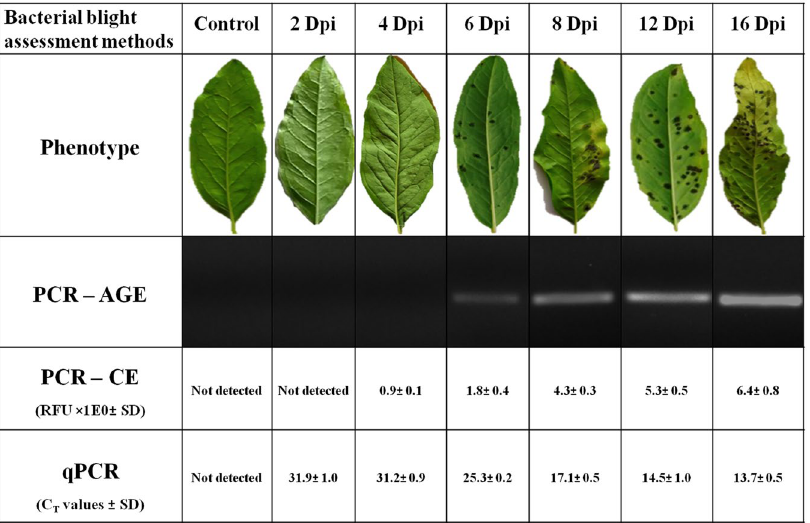
Figure 3. Detection of Xanthomonas axonopodis pv. punicae (Xap) in pomegranate at different days post inoculation by molecular diagnostic techniques. PCR-AGE: Polymerase Chain Reaction coupled with Agarose Gel Electrophoresis, PCR-CE: Polymerase Chain Reaction coupled with Capillary Electrophoresis, qPCR: Real- time quantitative PCR, dpi: days post inoculation, RFU: relative florescence unit.